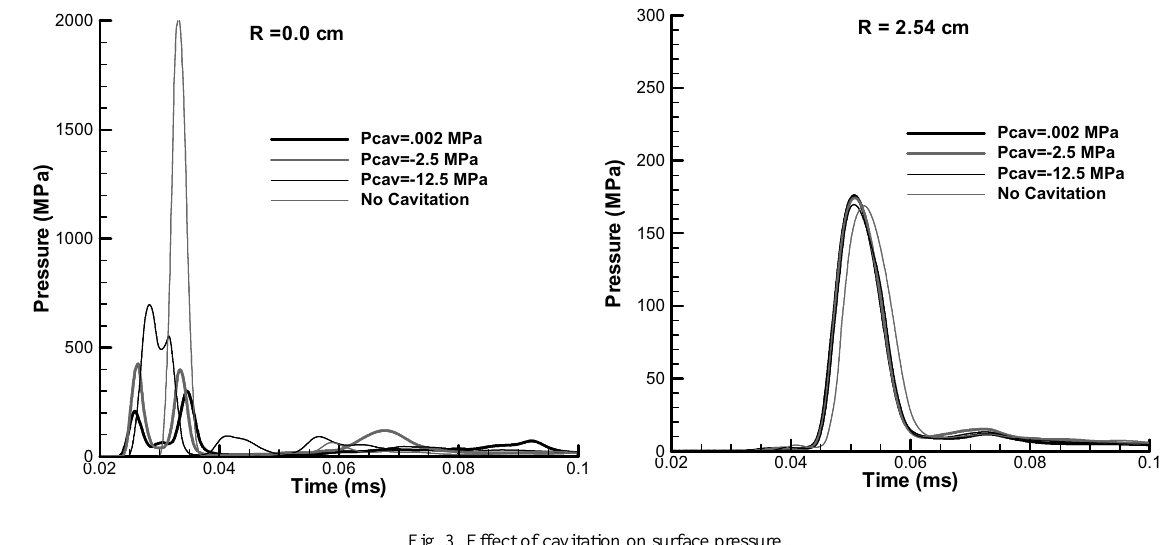
Fig. 3. Effect of cavitation on surface